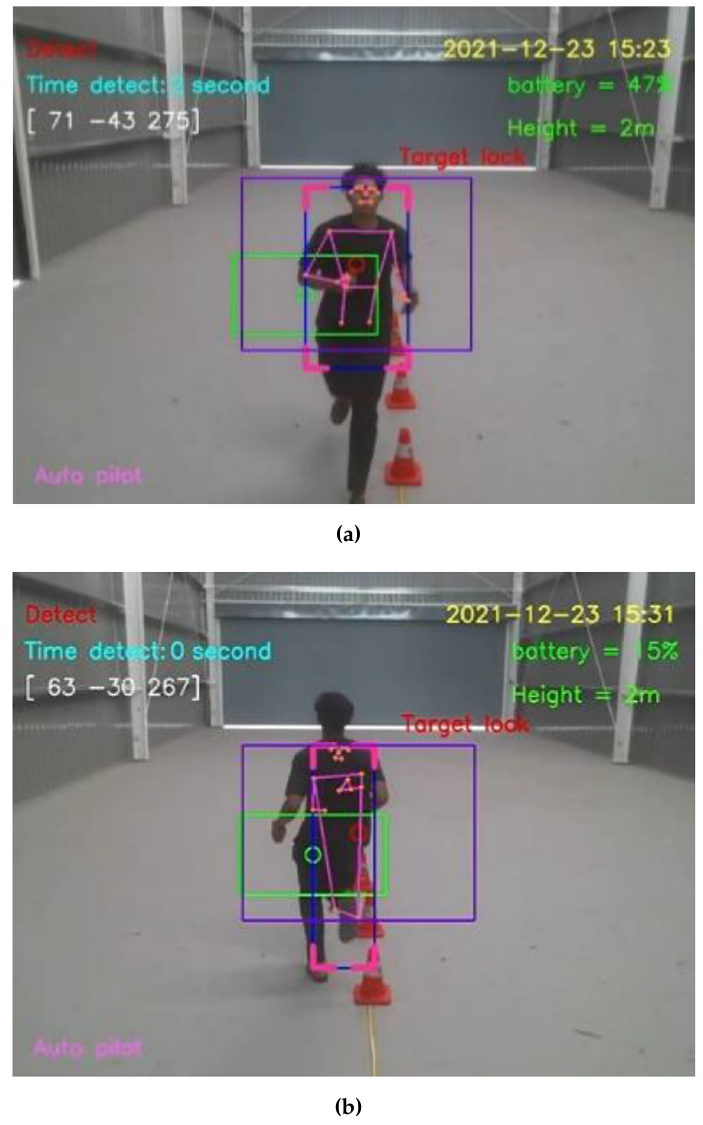
Figure 16. Straight moving directions: ( a ) Run forward to the Tello EDU drone ( b ) Run away from the Tello EDU